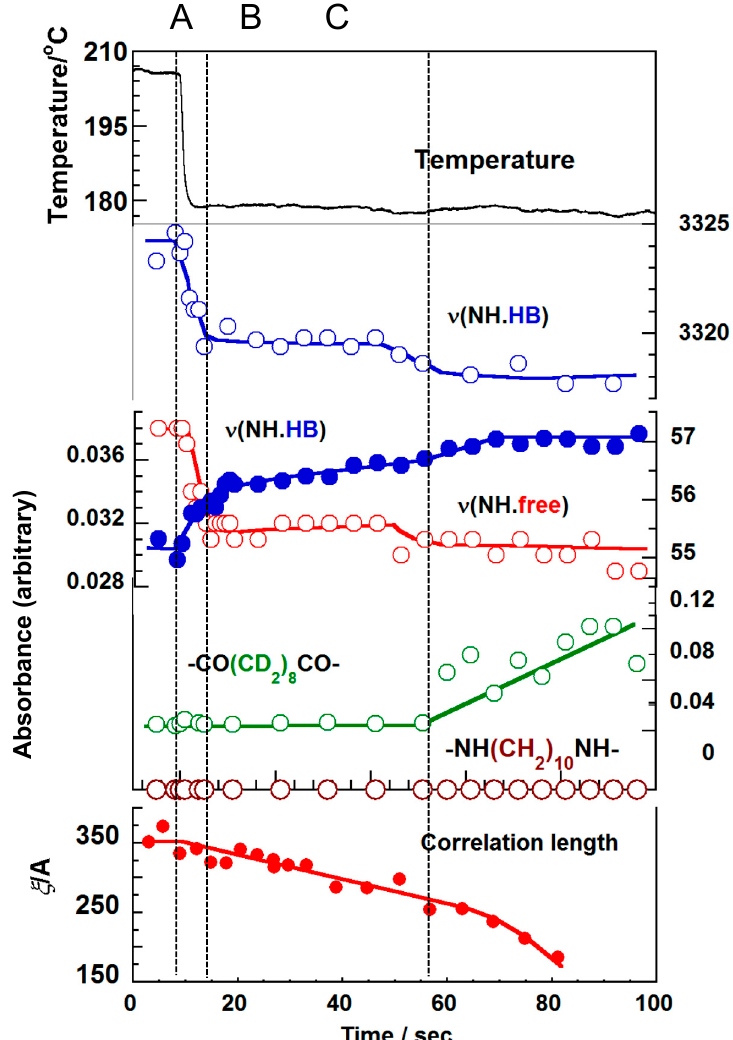
Figure 13. Time dependence of the various data measured for the partially-deuterated nylon 1010 sample in the isothermal crystallization from the melt [13].